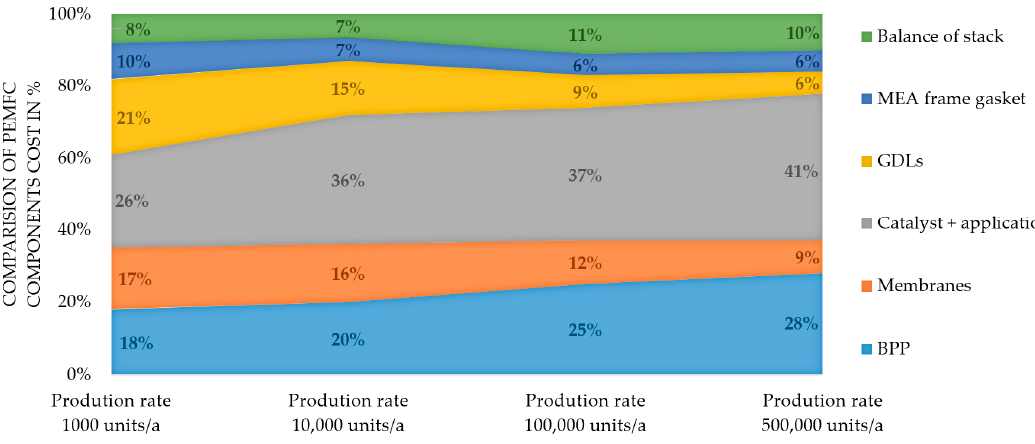
Figure 4. Breakdown of the 2017 projected PEMFC stack cost at 1000, 10,000, 100,000, and 500,000 units/a based on [4,9].